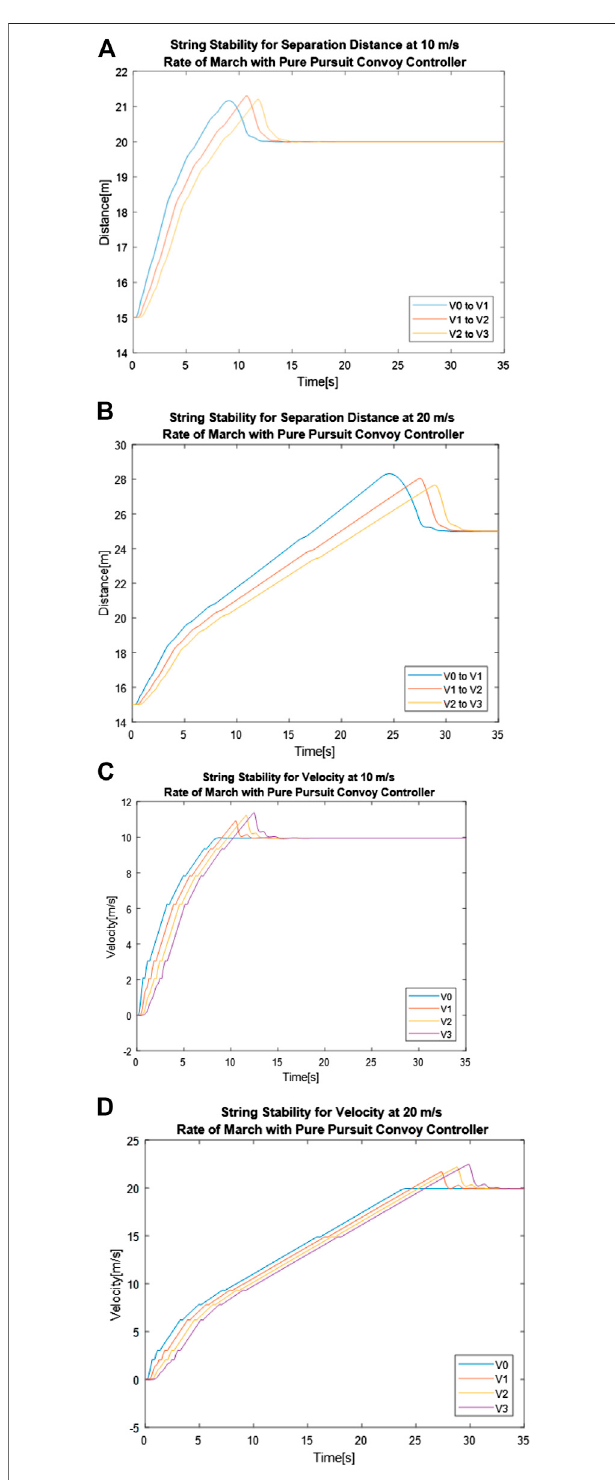
FIGURE 10 | Pure Pursuit convoy controller performance for separation distance between vehicles with a rate of march of (A) 10 m/s and (B) 20 m/s and velocity of vehicles over time with a gap distance of (C) 10 m/s and (D) 20 m/s.